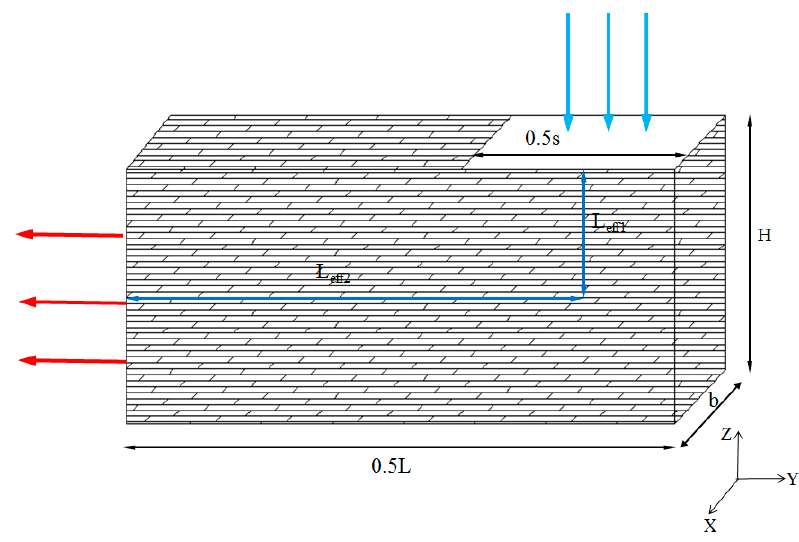
Figure 2. The simplified model.